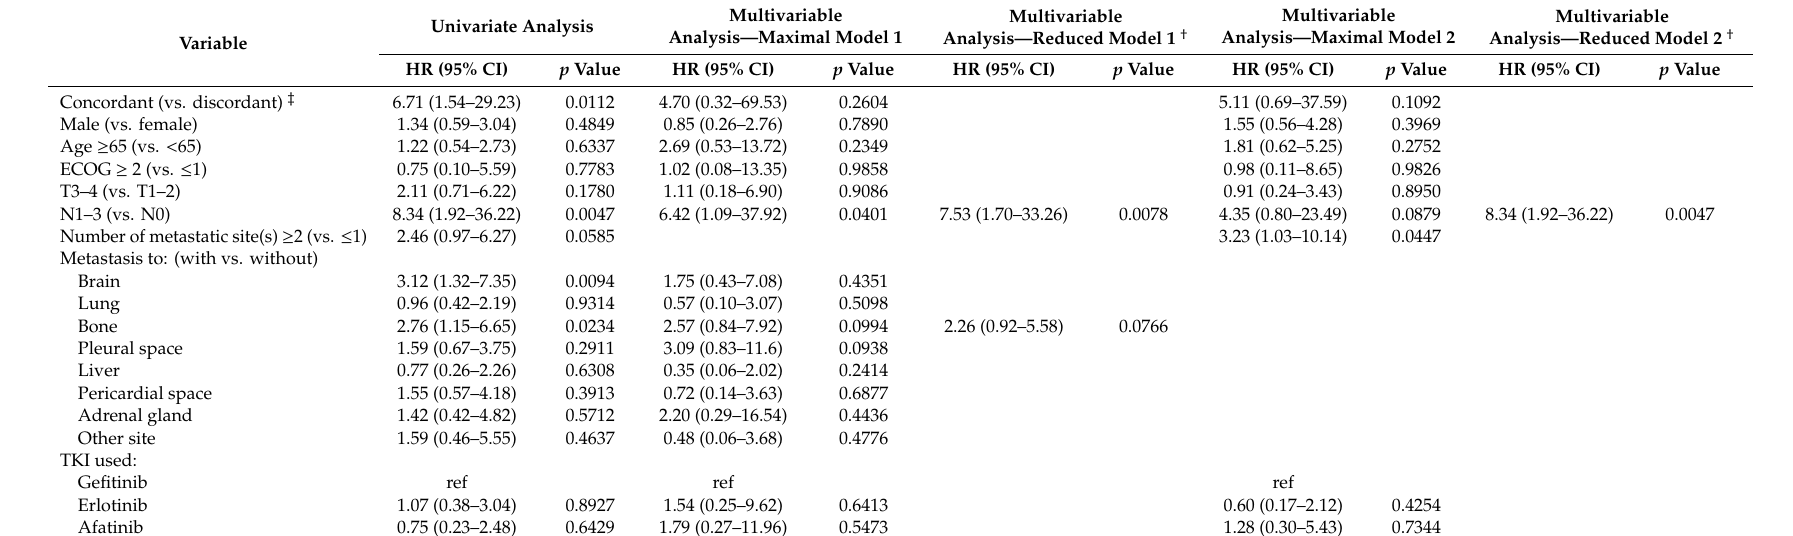
Table 4. Predicting factors for progression-free survival (PFS) in stage IV patients receiving first-line EGFR